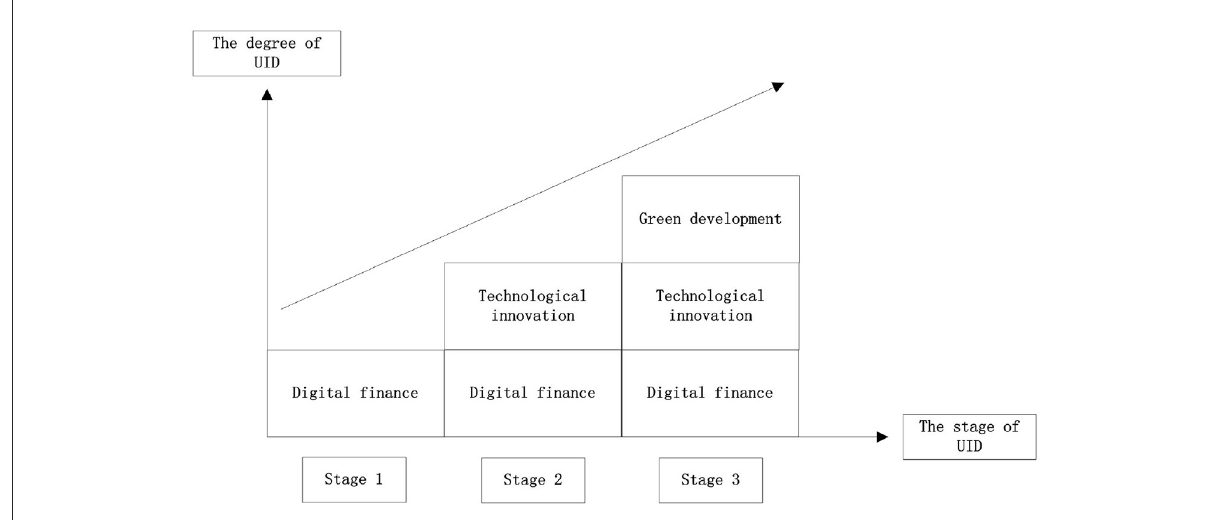
FIGURE5 The NSE framework of the